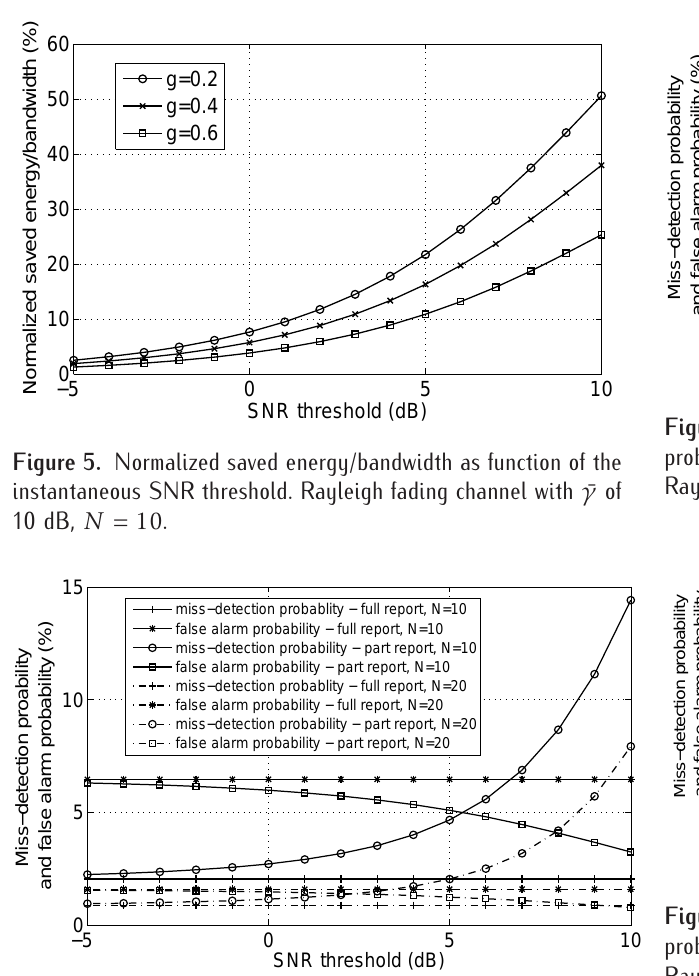
Figure 6. Fused miss-detection probability and fused false alarm probability at a R-CPE as function of the SNR threshold.